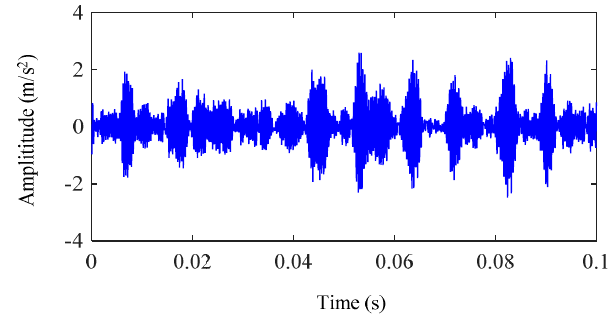
Figure 17. Time domain plot of the signal with outer race defect.